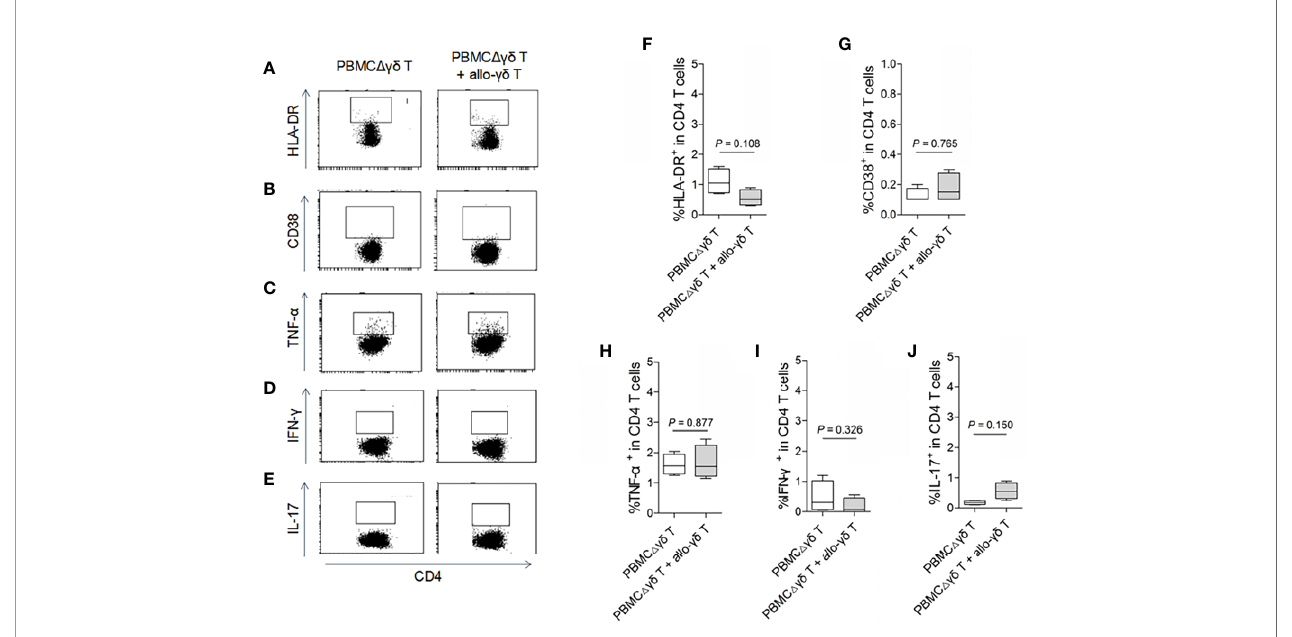
FIGURE 2 | Assay for the reactivity of CD4 T cells in response to stimulation of allogeneic gd T cells. MLRs were performed by co-culture of puri fi ed allogenic gd T cells with PBMC Dgd T cells isolated from healthy donors, at a ratio of 1:3. Cells were collected on day 5 after co-culture and stained with antibodies against CD4 (A – J) , HLA-DR (A, F) , CD38 (B, G) , TNF- a (C, H) , IFN- g (D, I) and IL-17 (E, J) . Data are expressed as the mean ± SD of triplicate cultures. P values are shown on the